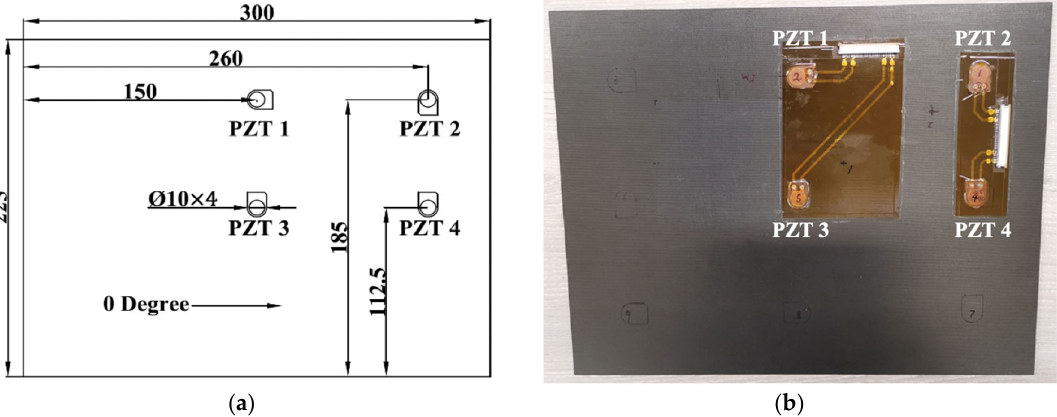
Figure 1. ( a ) Drawing of the specimen; ( b ) example of the composite panel with PZT transducers. After the printed Kapton ® films were ready, all soldering points for each PZT trans ‐ ducer and one side of high ‐ temperature connecting terminals (TML Co. TPF ‐ 2MS) were applied with small amounts of mixed conductive epoxy/hardener (RS 186 ‐ 3616). These PZT transducers and connecting terminals were placed at designated positions on the film. To cure the conductive epoxy/hardener, these Kapton ® films were subsequently placed into the oven to cure at 80 °C for 20 min. After that, two layers of adhesive films were placed on the designated positions of each panel, followed by Kapton ® films with printed circuits and integrated PZT transducers. Finally, these panels were then cured at 150 °C for 1 h with a vacuum until cooling down to room temperature. After bonding, all edges were trimmed by a cutting machine, and two connectors (RS 514 ‐ 4408) were mounted on the designated edges of each panel bonded by a superglue (RS 473 ‐ 445). Then, these connecting terminals were soldered to connect to the two connectors of each panel. 3. Dispersion Curves In this section, the dispersive curves based on the analytical method [41] were plotted to study the thickness influence on the group velocities of the S 0 and the A 0 modes. Figures 2–4 plot the dispersion curves of quasi ‐ isotropic panels for the 2 mm, 4 mm and 9 mm thick panels at 0°, respectively. According to these figures (Figures 2a, 3a and 4a), the shapes of these curves look similar, and the only difference is their frequency range. Fig ‐ ures 2b, 3b and 4b show the dispersion curves from 0 to 250 kHz, which clearly showed the group velocity of the A 0 and the S 0 modes at 250 kHz became closer when increasing the thickness. This means the thickness greatly affected the group velocity of the S 0 mode at 250 kHz.